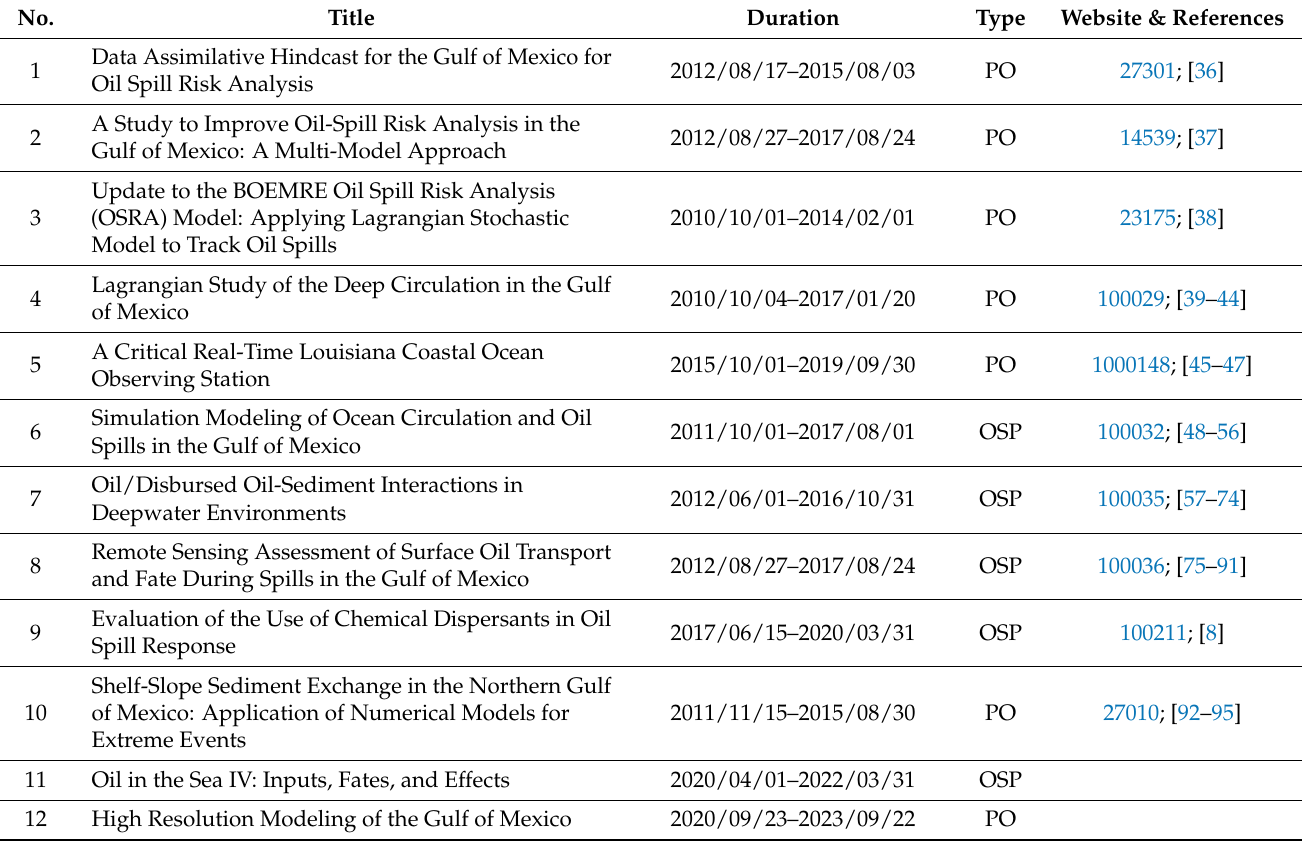
Table 1. Summary of ESP studies supporting Oil Spill Modeling (OSP) and Physical Oceanography (PO), including numerical simulations, field observations and sediment transports in the GOM since the DWH oil spill.